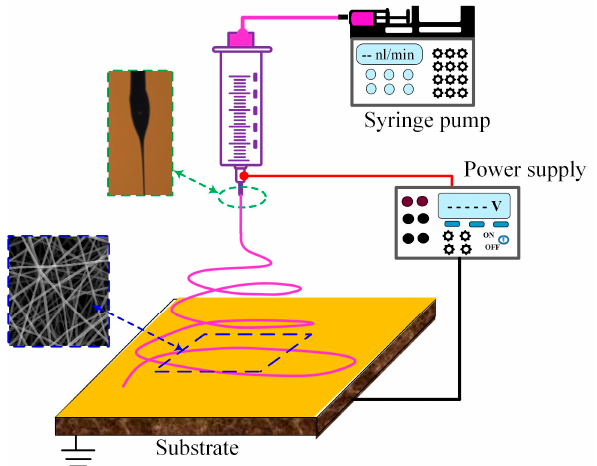
Figure 1. Schematic illustration of an electrospinning.